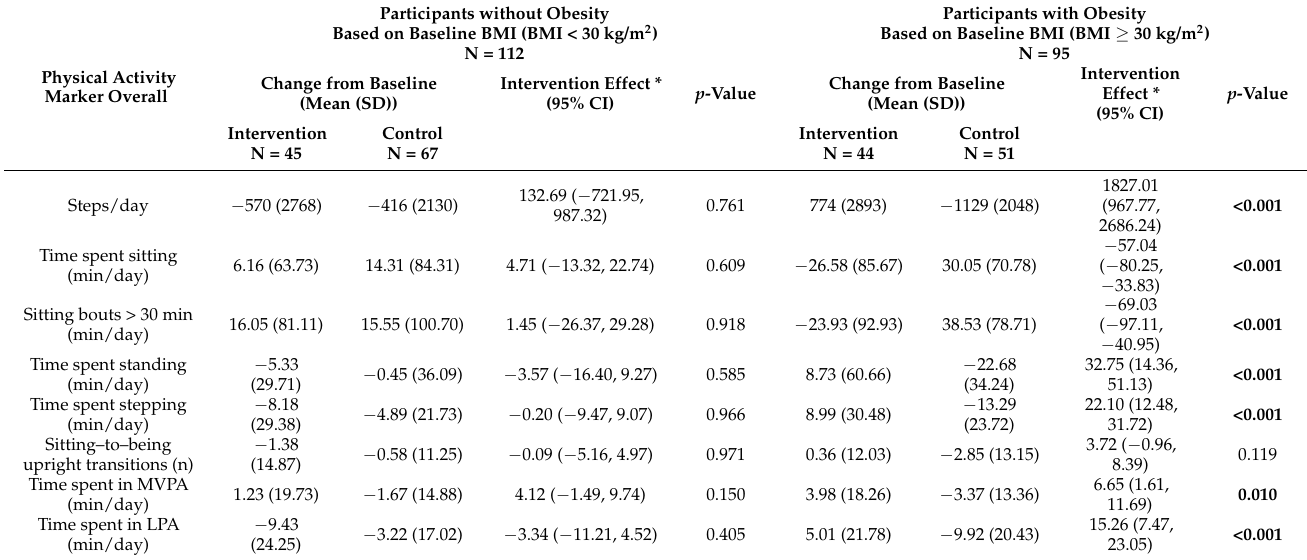
Table 2. Physical activity and sitting behaviours measured across all valid days for participants with and without obesity based on